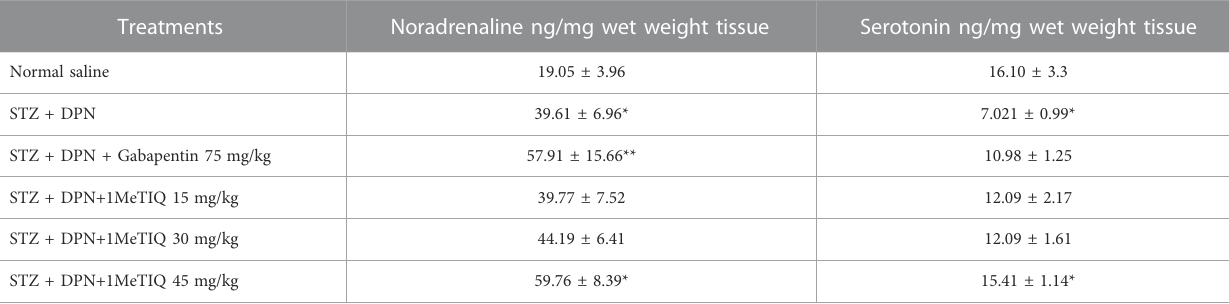
TABLE 1 Concentrations of neurotransmitters in frontal cortex tissue after the streptozotocin protocol (i.e., STZ + DPN) alone or combined with gabapentin or 1MeTIQ. Note: * p < 0.05, ** p < 0.01.